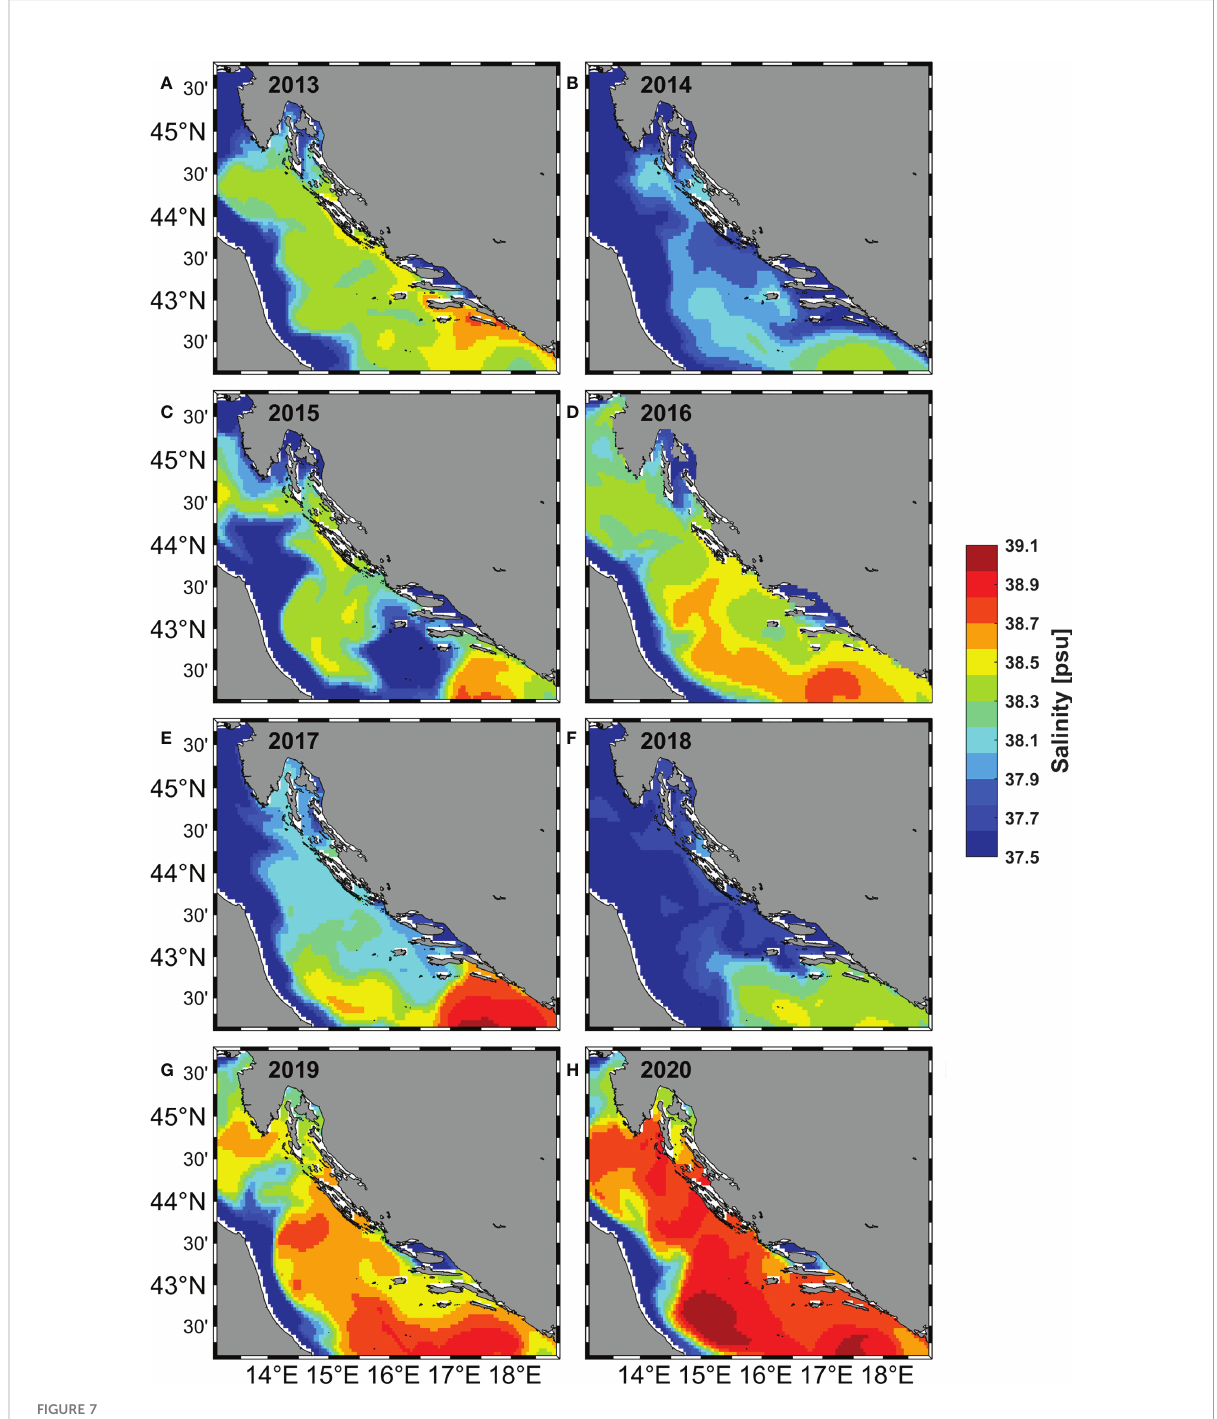
FIGURE 7 Monthly average map of the modelled salinity at 10 m depth in the Adriatic Sea for the month July in the period 2013 – 2020 (A – H)